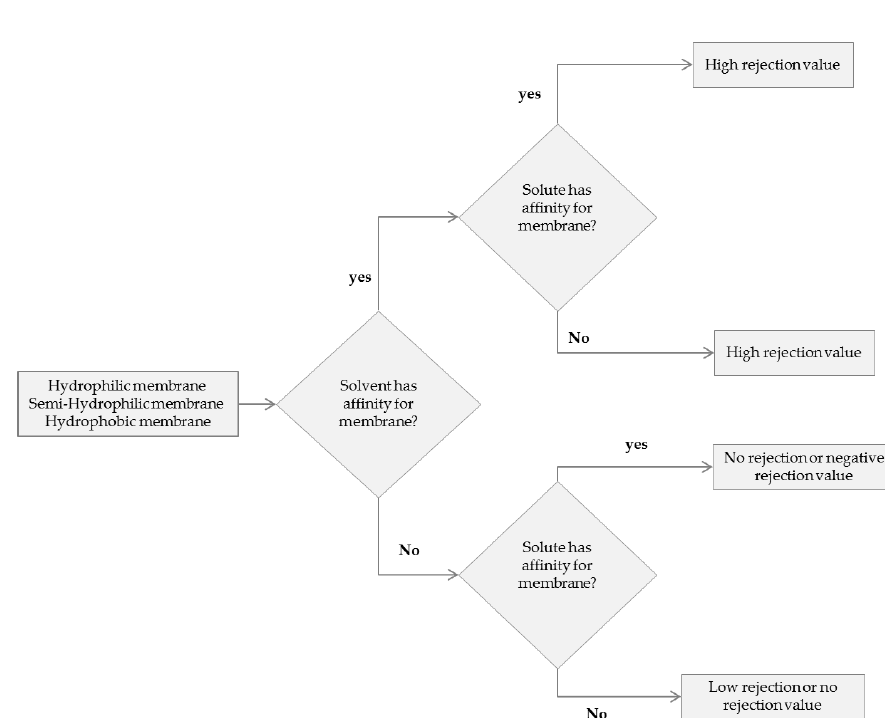
Figure 6. Scheme to predict the expected rejection of solutes with a given membrane. Solute and solvent affinity can be evaluated by the hydrogen-bonding ability of the membrane.